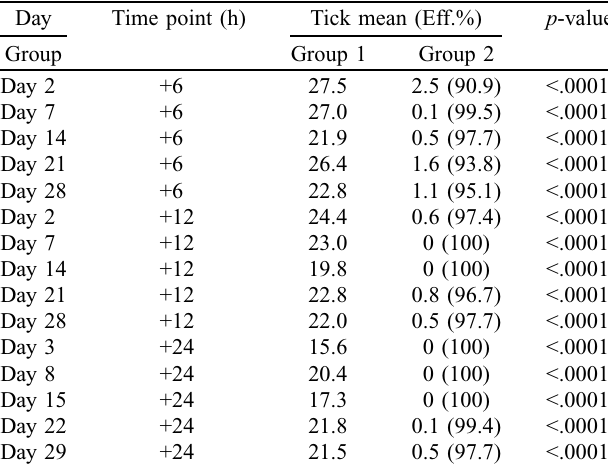
Table 2. Efficacy against Rhipicephalus sanguineus (arithmetic